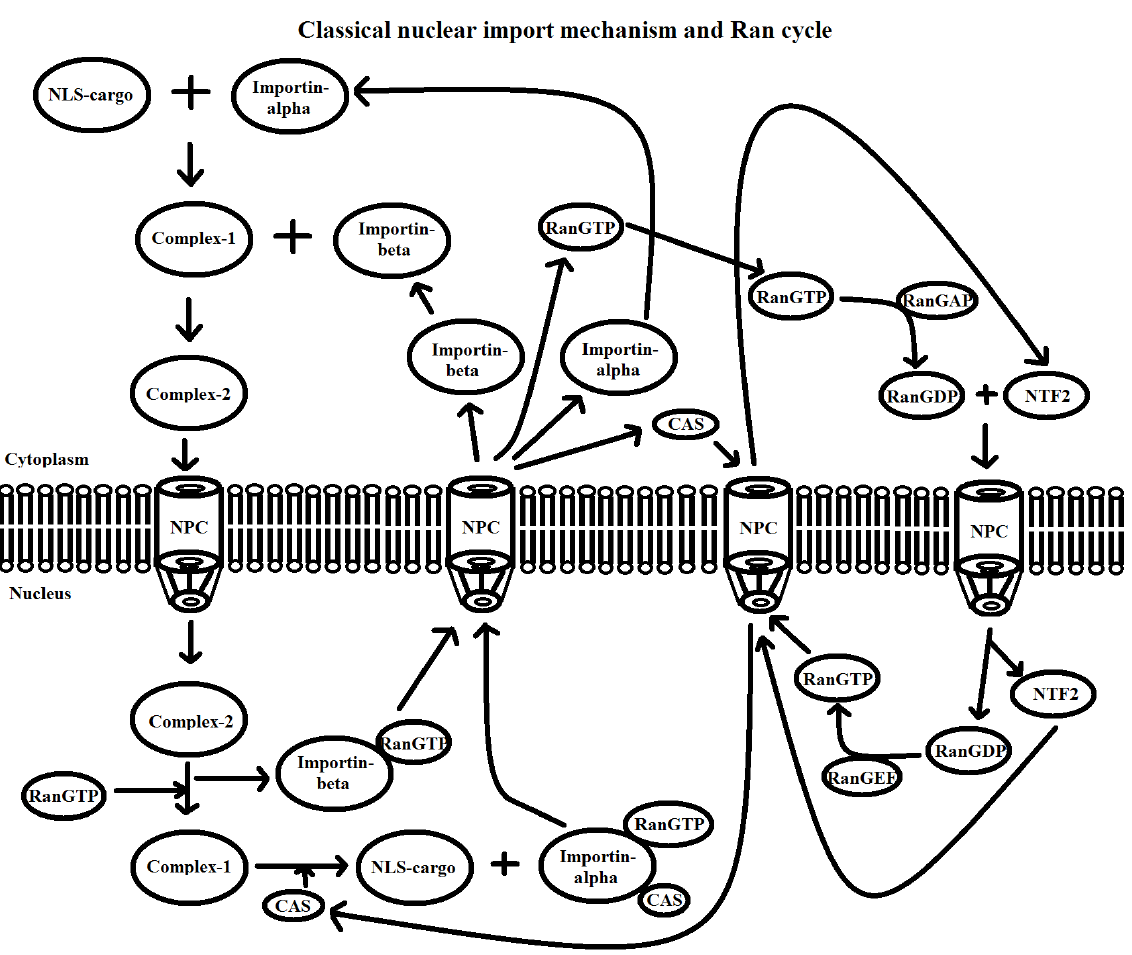
Figure 2: Classical nuclear import mechanism and Ran cycle. Mature miRNA (NLS-cargo) is transported across the nuclear membrane via the nuclear pore complex (NPC) assisted by several factors like importins, exportins and RanGTP. Drawn based on the information from the references [36, 39, 40, 48-52] and used in the present